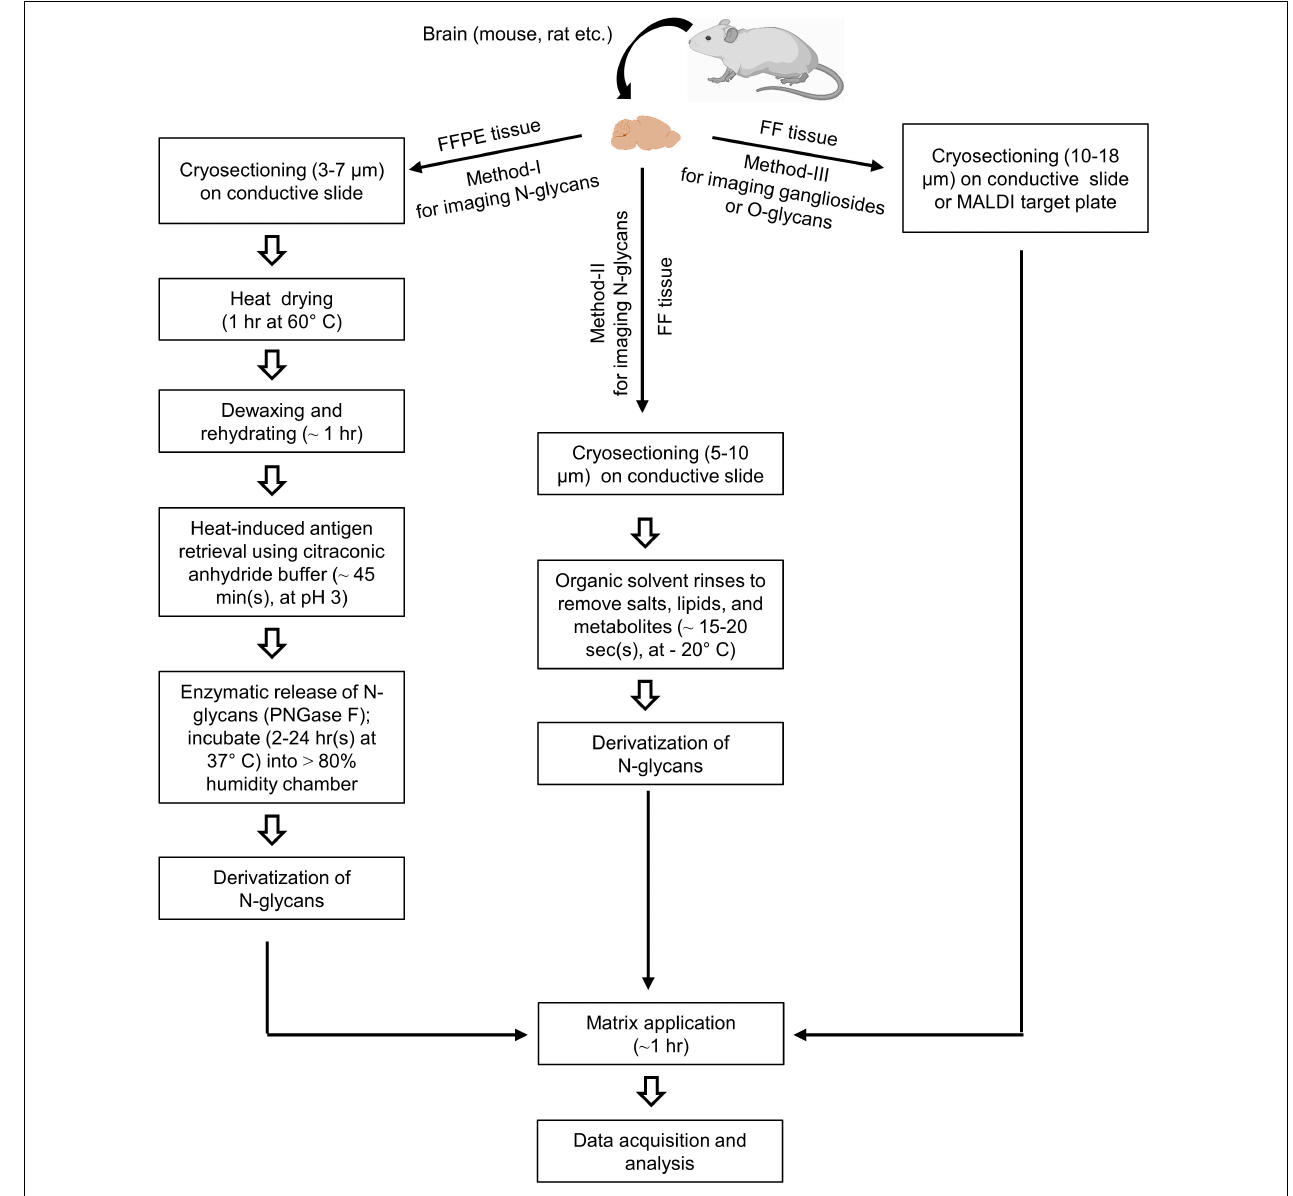
FIGURE 1 | Schematic workflow of mass spectrometry imaging (MSI) for glycome in the brain. An FFPE tissue section is mounted on an indium tin oxide-coated (ITO-coated) glass slide and dried by heating. Then section is deparaffinized and rehydrated by xylene and a series of ethanol rinsing, respectively. The epitope activation and tissue proteins are denatured by the treatment with a basic heat-induced antigen retrieval buffer (citraconic anhydride buffer, at pH 3) (Method-I). On the other hand, FF tissue (Method-II) rinses in an organic solvent for removing salts, lipids, and metabolites. Another FF tissue is directly mounted on the conductive ITO-coated glass slide or MALDI target plate for matrix spraying and MSI analysis (Method-III). Enzymatic release of N-glycans is performed using PNGase F under incubation at 37 ◦ C (Method-I). On-tissue derivatization is required (Method-I and II) before matrix deposition to stabilize glycans and enhance the ionization efficiency. After automated matrix spraying, the sections are subjected to a laser source for data acquisition and